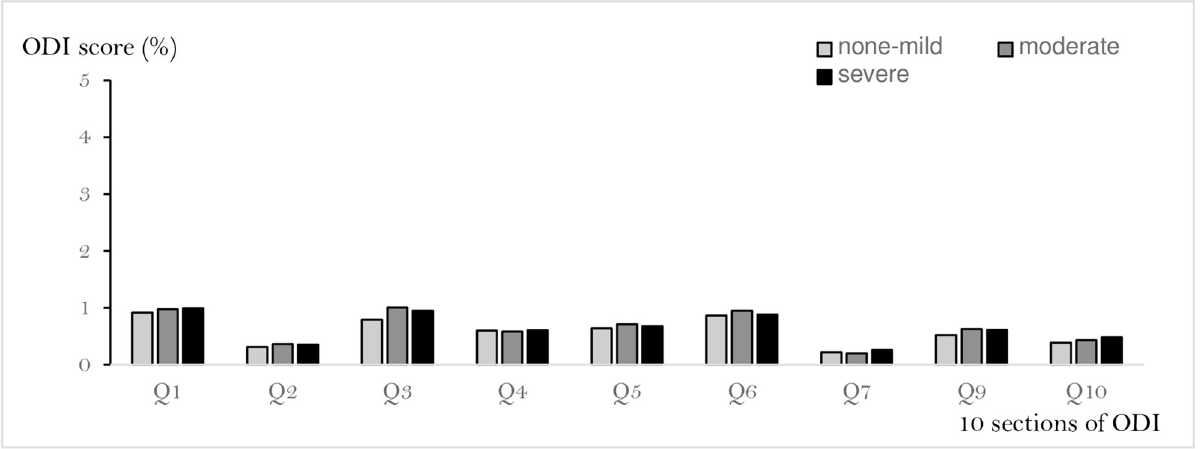
Fig 5. The score of each 10 sections of ODI vs radiographic LSS. This figure shows the association of the severity of radiographic LSS (severe, moderate, non-mild) with average score (%) for each question were as follows: question 1 (0.92%, 0.98%, and 1.0%, respectively), question 2 (0.32%, 0.37%, and 0.35%, respectively), question 3 (0.79%, 1.01%, and 0.95%, respectively), question 4 (0.6%, 0.58%, and 0.61%, respectively), question 5 (0.64%, 0.71%, and 0.68%, respectively), question 6 (0.87%, 0.95%, and 0.89%, respectively), question 7 (0.22%, 0.20%, and 0.26%, respectively), question 9 (0.52%, 0.86%, and 0.97%, respectively), and question 10 (0.39%, 0.67%, and 0.48%, respectively). There was no significant difference in the ODI scores of any of the questions by the severity of radiographic LSS. We also excluded the Q8 associated sexual function.